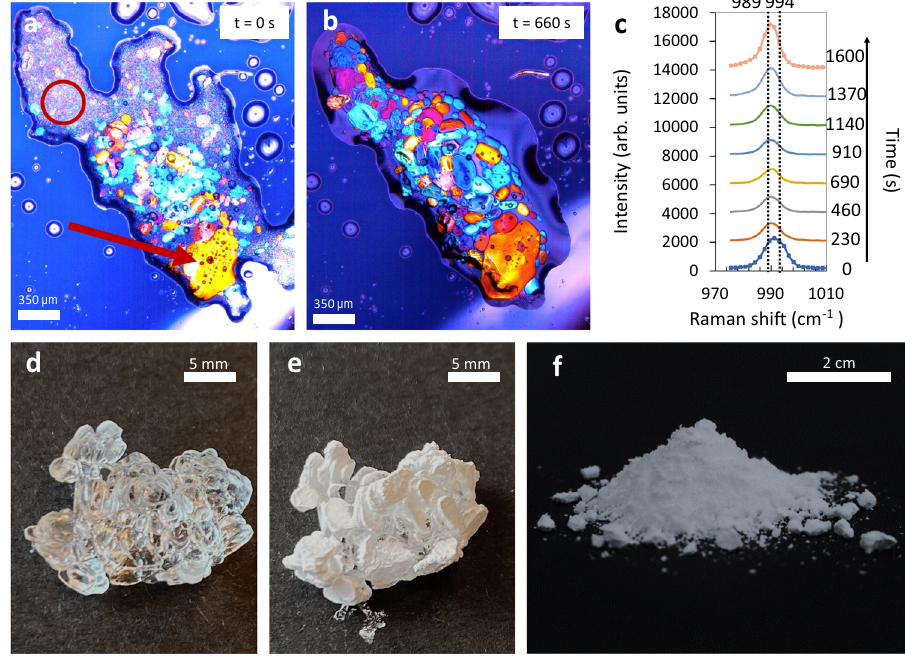
Fig. 1 | Gradual deliquescence of thenardite (Na 2 SO 4 ) polycrystals and rapid precipitation of mirabilite (Na 2 SO 4 ·10H 2 O) microcrystals. a, b Microscopy images madewith crosspolarizersof the deliquescenceprocessof thedehydrated powder. The colors that are seen with cross-polarized light highlight the fact that whatwe are seeing isnot aliquidstructure. a Initially, both polymorphs (mirabilite andthenardite)coexist,asshownbytheRamanspectraoftheregioncircledinred. The red arrow shows entrapped remaining thenardite nanocrystals (black dots) in the mirabilite crystals. This has been con fi rmed by Raman spectroscopy of the ‘ black spots ’ and the crystal surrounding these spots, and subtracting them (see